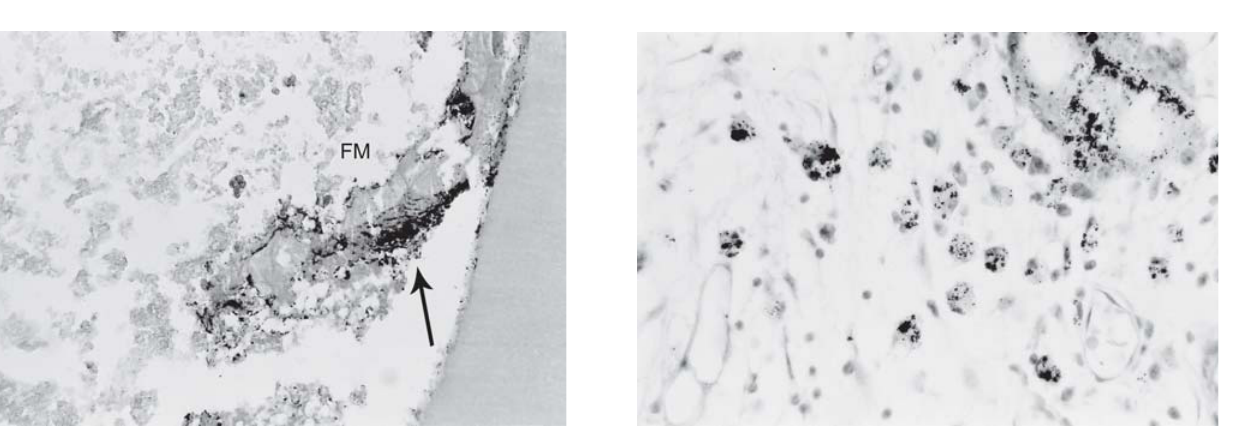
FIGURE 5 - L&C paste. There are Gram-positive microorganisms (arrow) in debris next to the filling material (FM). Brown and Brenn. X 200